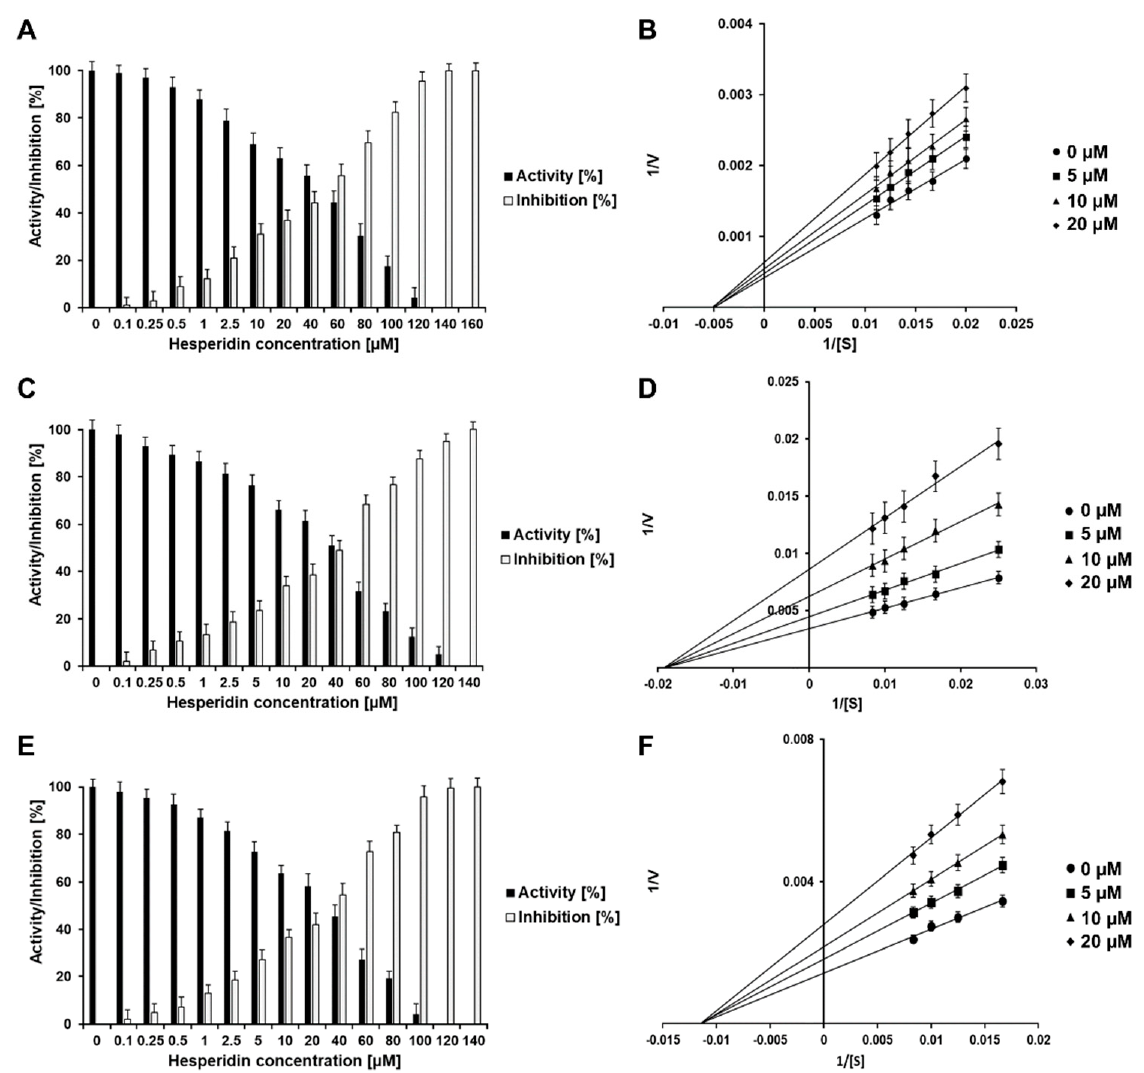
Figure 4. Normalized activity, inhibition effect and inhibition mode of HSD over DENV2, YFV, and WNV NS2B/NS3 pro . Lineweaver-Burk plots were used to determine the inhibition mode of HSD. [S] is the substrate concentration; v is the initial reaction rate. Inhibition of DENV2, YFV, and WNV NS2B/NS3 pro by HSD are shown in ( A , C , E ), respectively. Lineweaver-Burk plot for HSD inhibition of DENV2 NS2B/NS3 pro . Inhibition of YFV NS2B/NS3 pro by HSD is shown in ( B , D , F ). Data shown are the mean ± SD from 3 independent measurements ( n = 3).